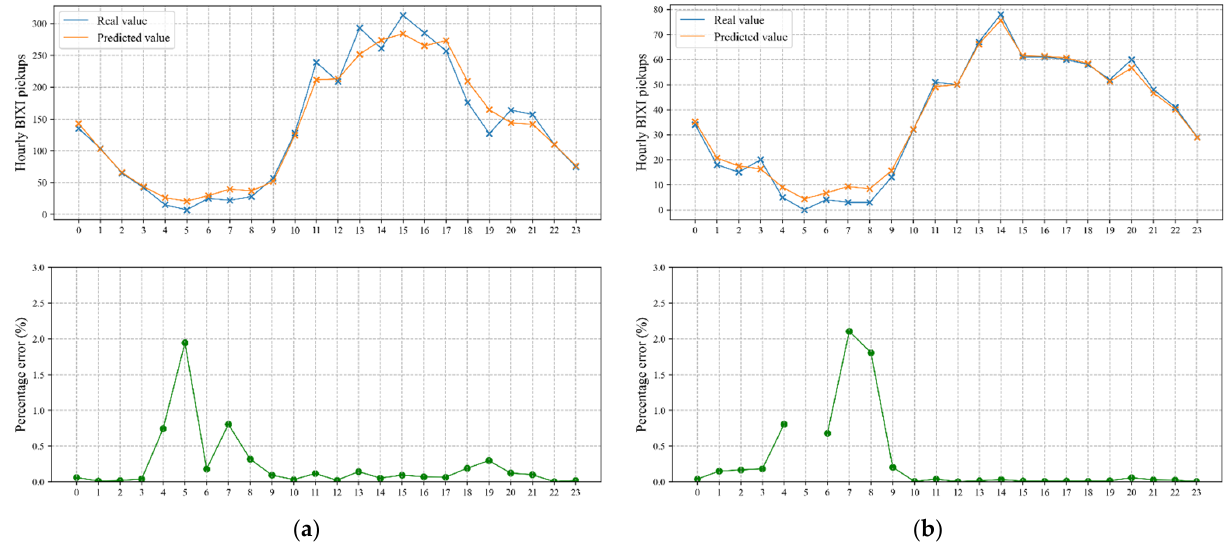
Figure 8. Real and predicted time series as well as the corresponding percentage error of two selected communities on test data for the selected date 19th August 2020. ( a ) Community 3; ( b ) Community 6.